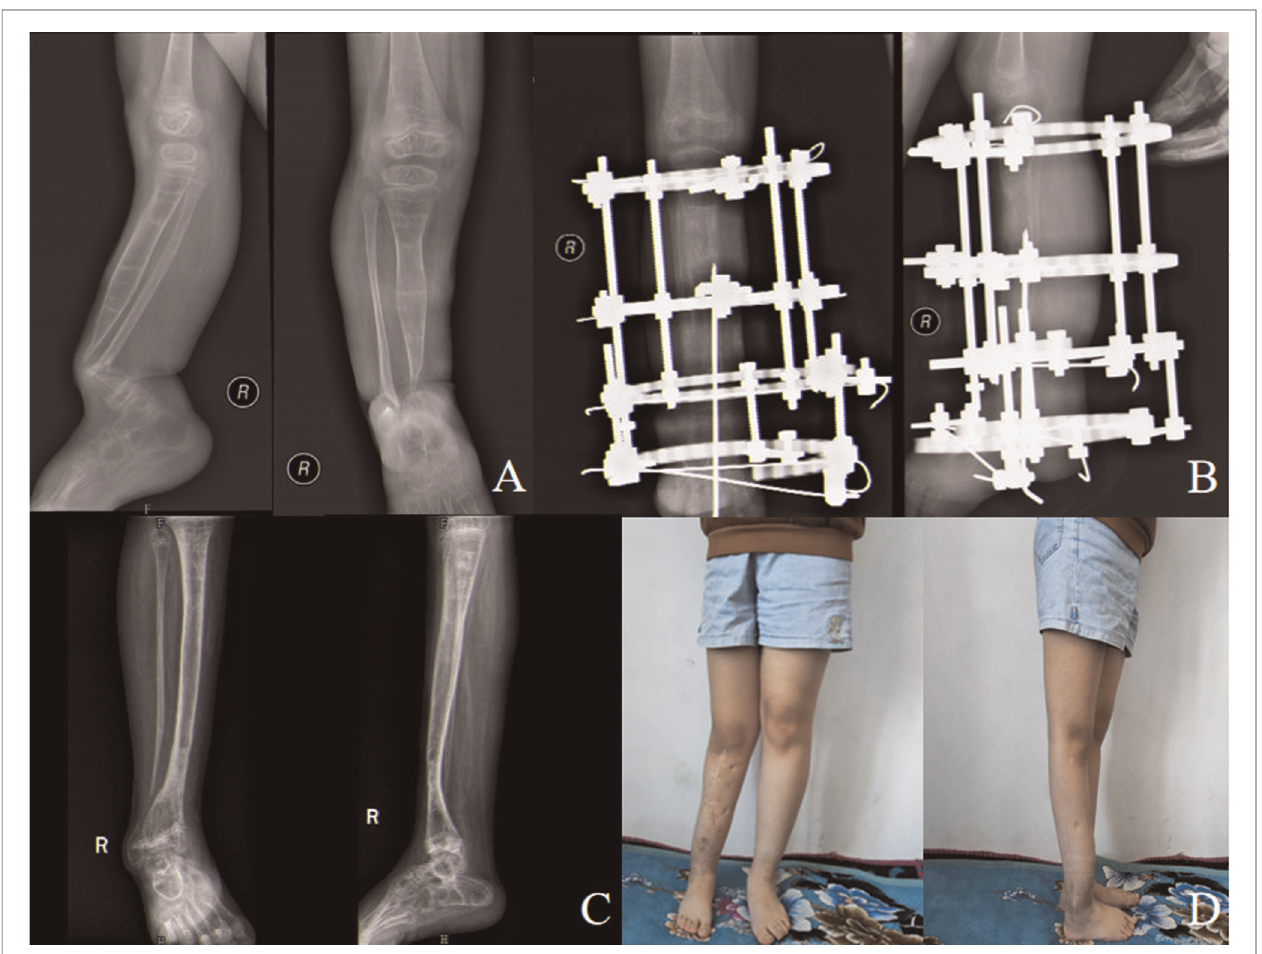
FIGURE 2 | Typical case of a 5.5-year-old girl with congenital pseudarthrosis of the tibia. ( A ) Preoperative anteroposterior and lateral X-ray showing Crawford type IV CPT and intact fi bula. ( B ) Anteroposterior and lateral X-ray fi lms at 98 days after operation, showing good consolidation of distracted region. ( C ) Anteroposterior and lateral radiographs at 40 months after removal of the external fi xator, showing a well-aligned tibia and bone union. Thirty-six months after the external fi xator was removed, the intramedullary K-wire was removed in order to restore the range of motion of the ankle joint. ( D ) Forty-one months after removal of the external fi xator, the patient ’ s standing and walking function recovered.